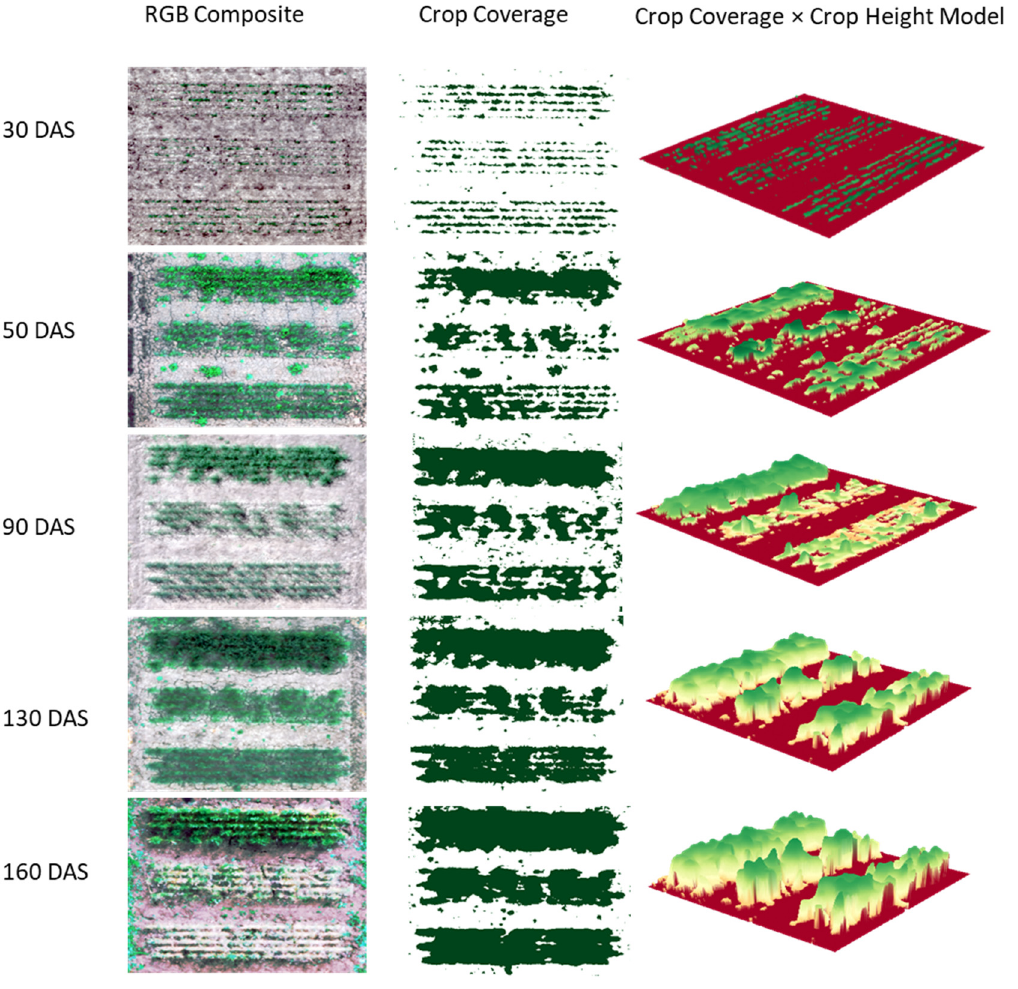
Figure 4. A visual evaluation of the performance of the employed workflow for computing intermediate metrics—crop coverage (CC) and crop volume (CV) at different growth stages (30, 50, 90, 130 and 160 DAS) on three genotypes. The classified CC and CC × VIs images are compared against RGB composite images generated using multispectral bands blue (475 nm), green (560 nm) and red (668 nm).